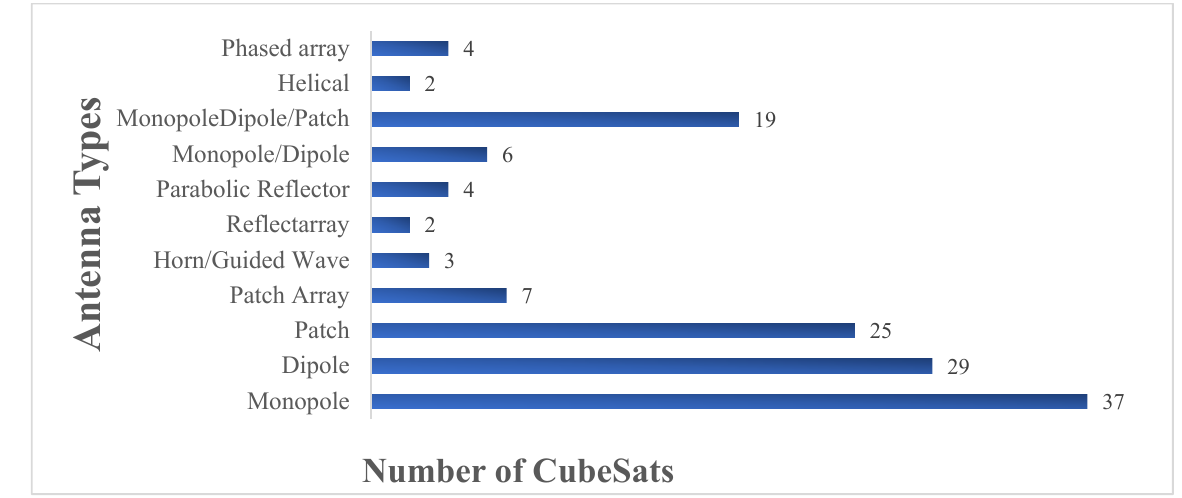
Figure 5. Antenna types used in the 120 CubeSat missions presented in Table 4.